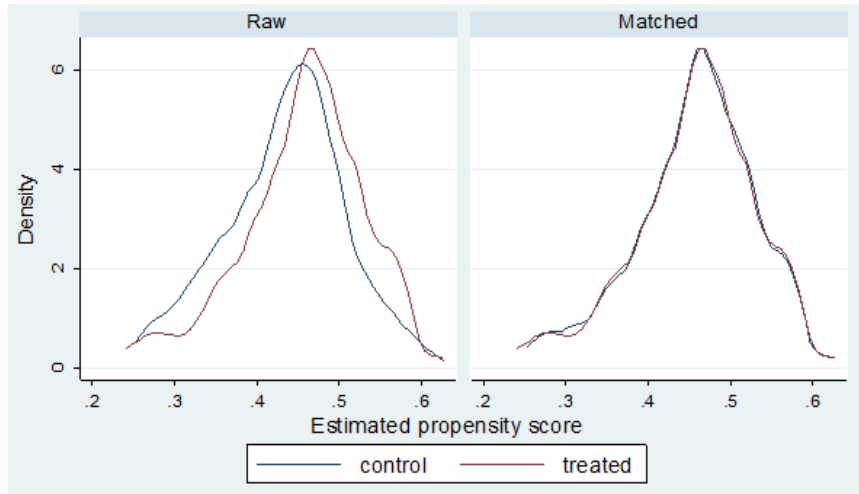
Figure 2: Distribution of Estimated Propensity Scores of Treatment and Control Groups, Before And After Matching